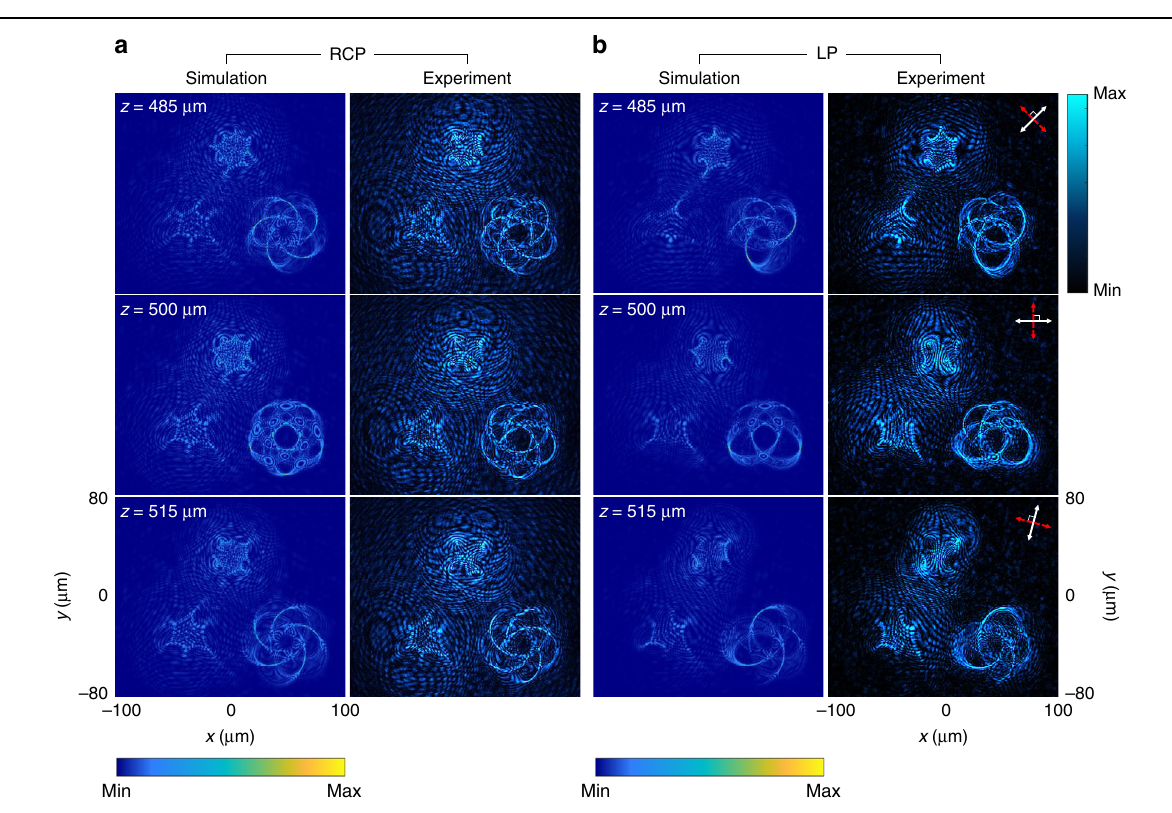
Fig. 6 Simulation and experimental results of the selected 3D polarization knots at λ = 500 nm. a The intensity distribution at different observation planes upon the illumination of RCP light. b Polarization structure detection with different combinations of transmission axes of the fi rst polarizer and the second